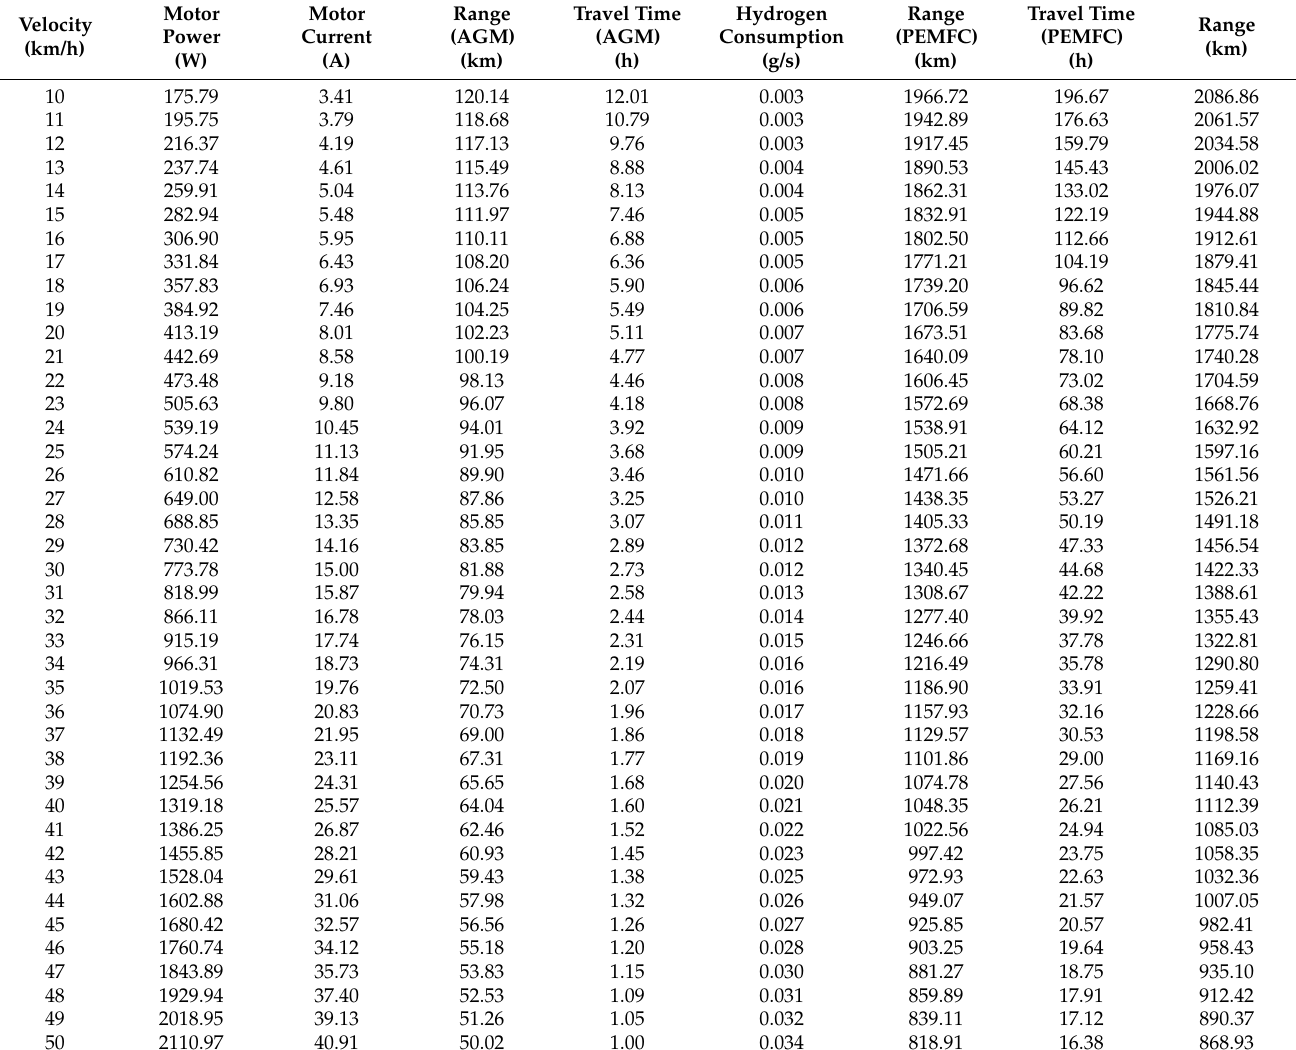
Table 1. The data generated from the